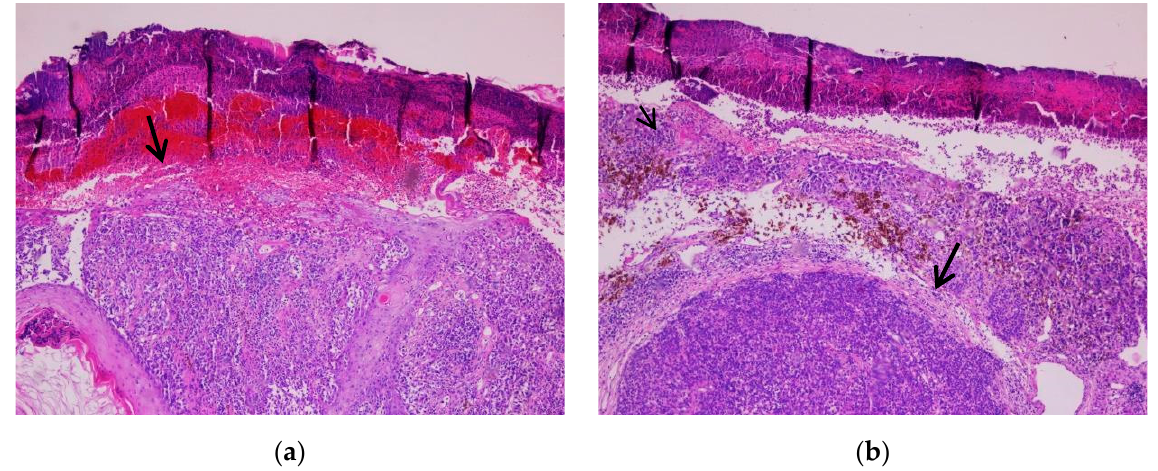
Figure 3. Nodular melanoma. ( a ) Ulcerated epidermis. A tumoral proliferation with solid architecture is seen underneath (arrow). ( b ) Ulcerated epidermis. Nodules of tumoral cells were observed beneath the ulceration (large arrow). Melanophages and pigmented tumoral cells (small arrow) are also evident. Both images were taken at 5× magnification. (Collection of Pathology Department SCJ Mure ș ).